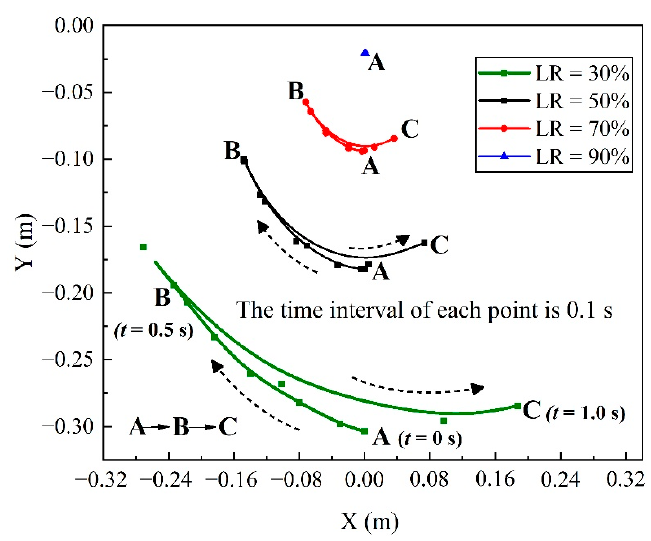
Figure 7. Centroid displacements of liquid with different